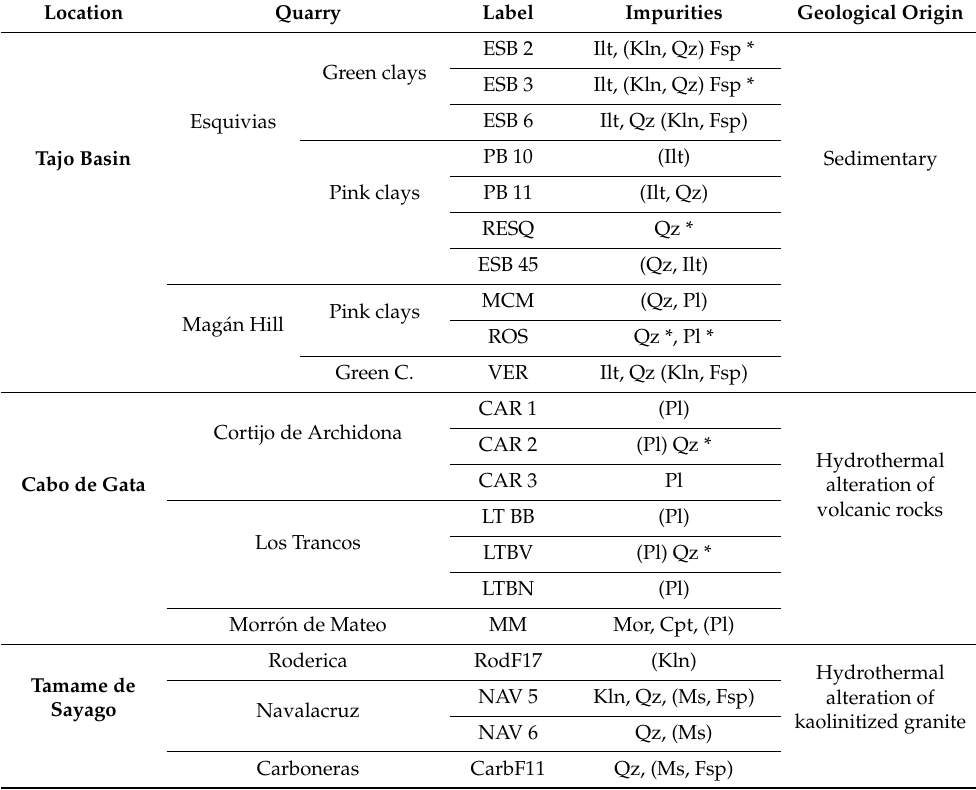
Table 1. Main data of the studied samples, including location, labeling, approximate mineralogical composition (from X-ray powder di ff raction (XRD) data), and geological origin. “Impurities” refers to the minerals that appear with the smectite: the order is related to the abundance, starting with the most abundant. Minerals between brackets are ≤ 5% in weight, and minerals with “*” are at trace levels. Alu: alunite, Cpt: clinoptilolite, Fsp: feldspar, Ilt: illite, Kln: kaolinite, Ms: muscovite, Pl: plagioclase, Qz: quartz, and Stb: